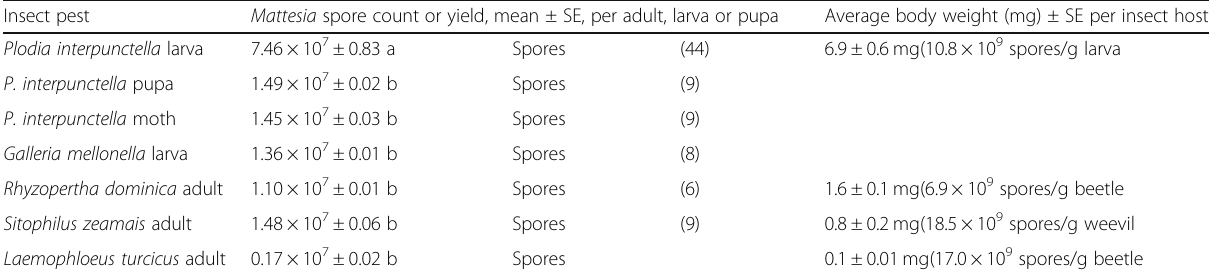
Table 1 Haemocytometer-average spore yield per Mattesia -infected adult, larva, or pupa of certain stored product insect pests Insect pest Mattesia spore count or yield, mean ± SE, per adult, larva or